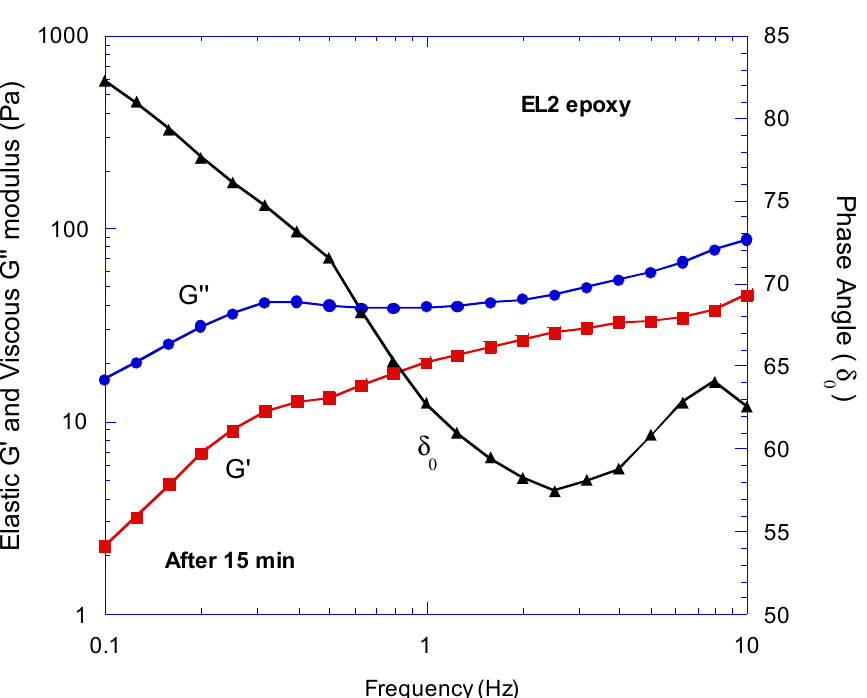
Figure 3. Frequency sweep result of EL2 epoxy 15 min after the mixing of the hardener.